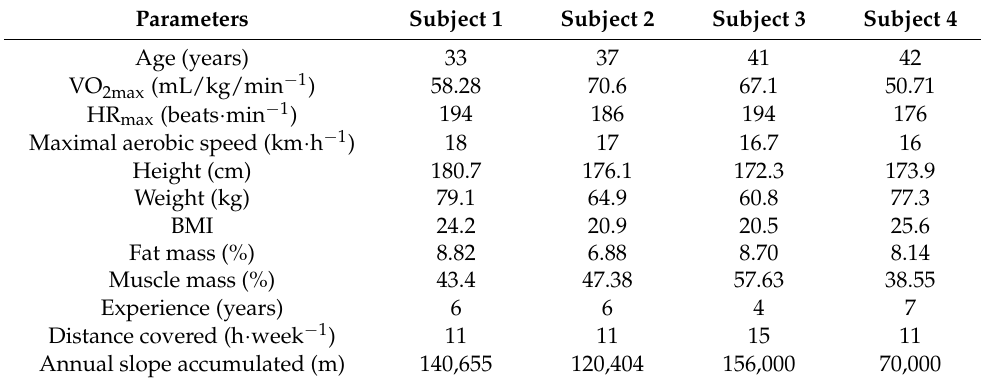
Table 1. Pre-race individual characteristics of the population included ( n = 4).